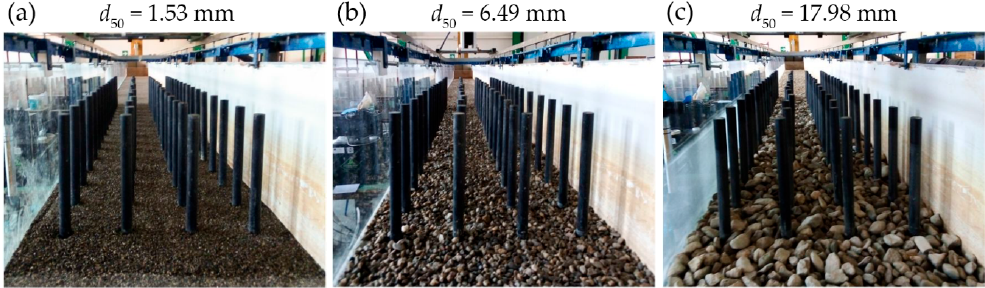
Figure 2. Laboratory flume for ( a ) Run 1, ( b ) Run 2, and ( c ) Run 3.